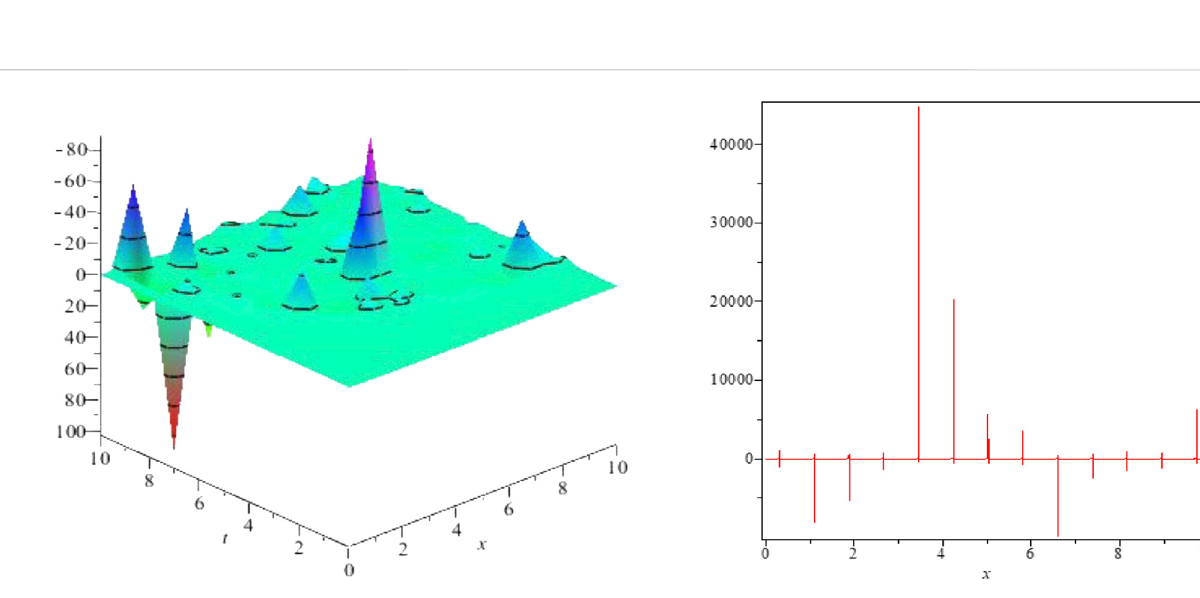
FIGURE 4 Kink-shaped solution for Eq. 35 for Y 23 at ω (cid:2) 1 , k (cid:2) 1 , a 0 (cid:2) 1 , a 1 (cid:2) − 1